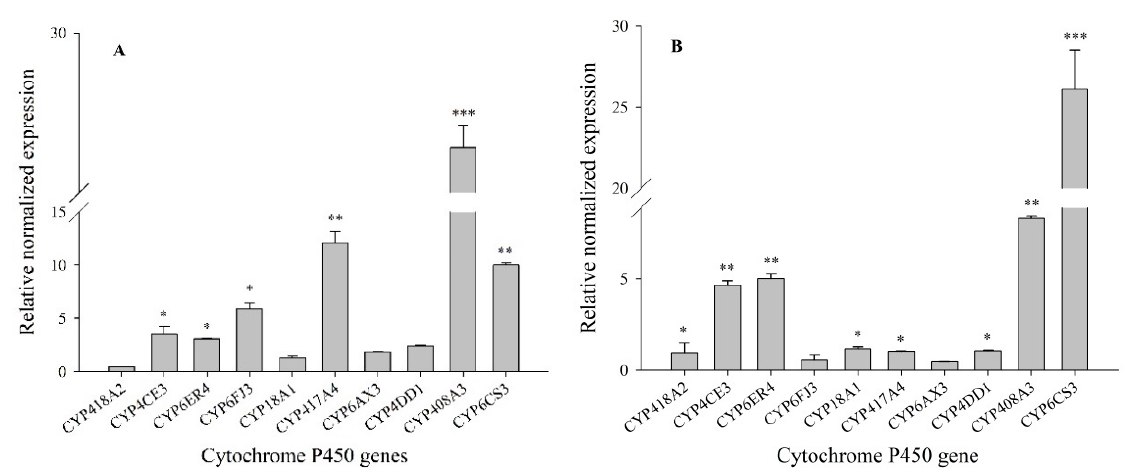
Figure 1. Relative expression qualities of select insecticide resistant-related P450 genes in the 3rd instar nymph resistant populations selected by a LC 50 dose of chlorpyrifos for 5 generations ( A ) and 6 generations ( B ) compared to the Lab-HN strain. The relative normalized expression was presented as the mean of three replications ± SE. The F 9, 20 values of the relative expression qualities of insecticide resistant-related P450 genes in the 3rd instar nymph of the XY17-G5 ( A ) and XY17-G6 ( B ) field populations were 378.54 and 100.745, and the p -values were = 0.0001 < 0.01. *, **, and *** showed significance at the 0.05, 0.01, and 0.001 levels with a Student’s t -test, respectively.